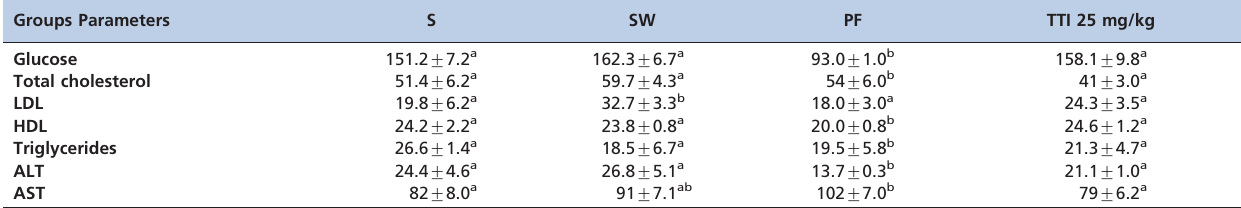
Table 2 - Biochemical parameters in Wistar rats subjected to the standard diet AIN-93G (S, n = 6), standard diet AIN- 93G + 1 mL of water (SW, n= 6), protein-free diet (PF, n = 6) and AIN-93G + 25 mg/kg tamarind trypsin inhibitor in 1 mL water (25 mg/kg TTI, n= 6) for 11 days. The results are expressed as the mean ¡ standard deviation of each group. Different letters indicate p , 0.05 between groups; one-way ANOVA followed by Tukey’s post-hoc test was used. Groups